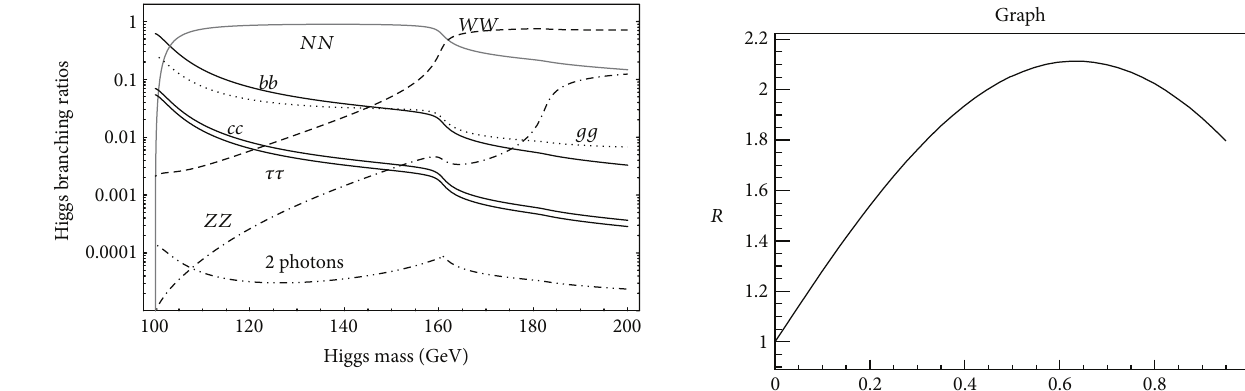
Figure 4: Branching ratios of the main processes of Higgs boson decay in the model of stable 4th generation (from [41]).